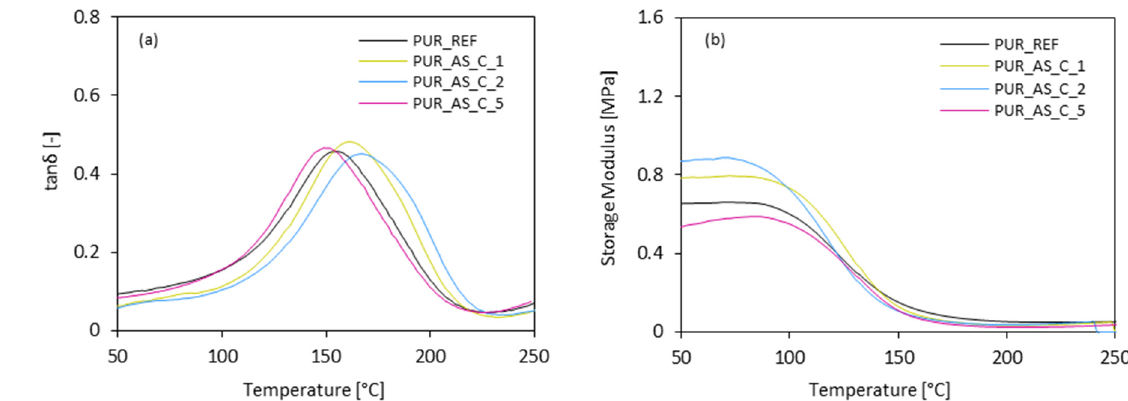
Figure 13. The results of dynamic mechanical analysis ( a ) tan δ and ( b ) storage modulus of PUR composites.